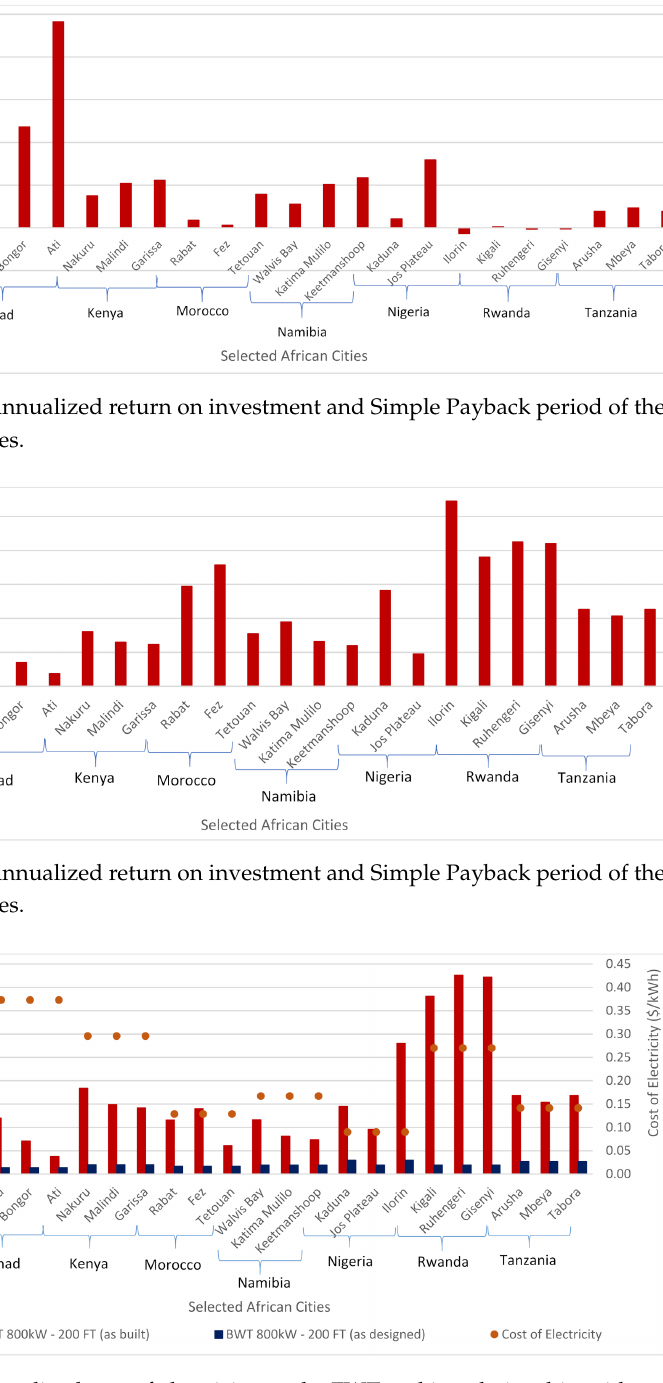
Figure 9. Levelized cost of electricity on the FWT and its relationship with cost of electricity in the selected African cities (Square = FWT Levelized Cost of Electricity; Circle = Cost of